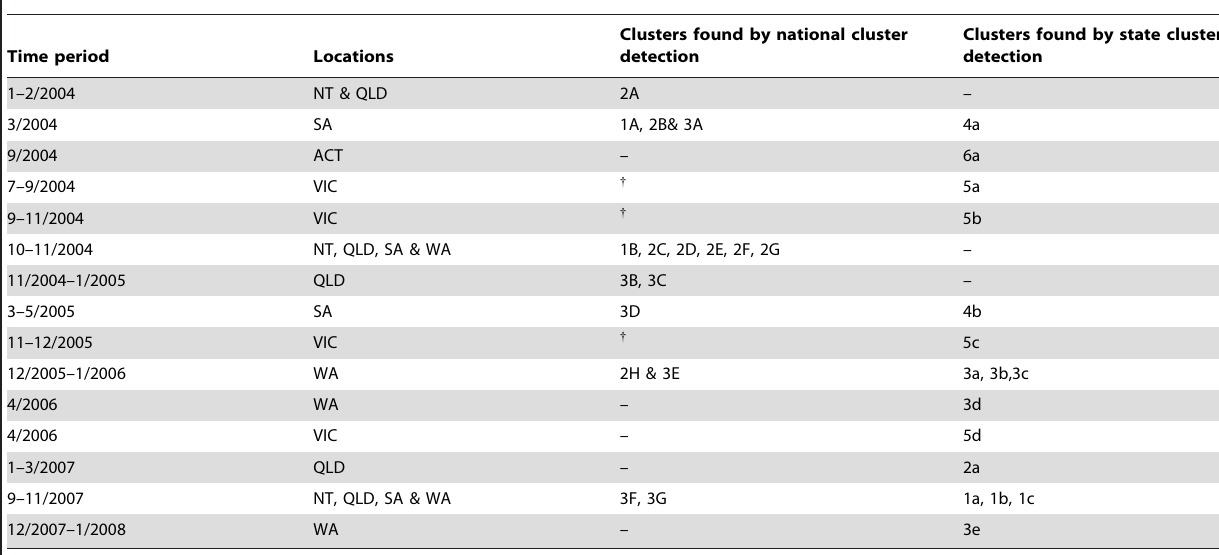
Table 4. Summary of suicide cluster streams from national and state cluster detection.